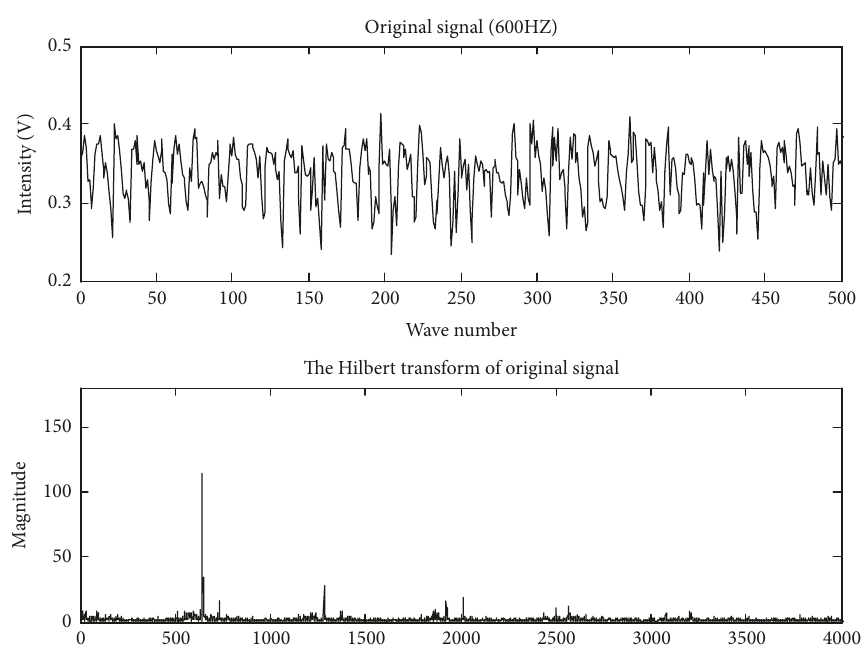
Figure 6: 600Hz sinusoidal driving original signal and spectrum variation